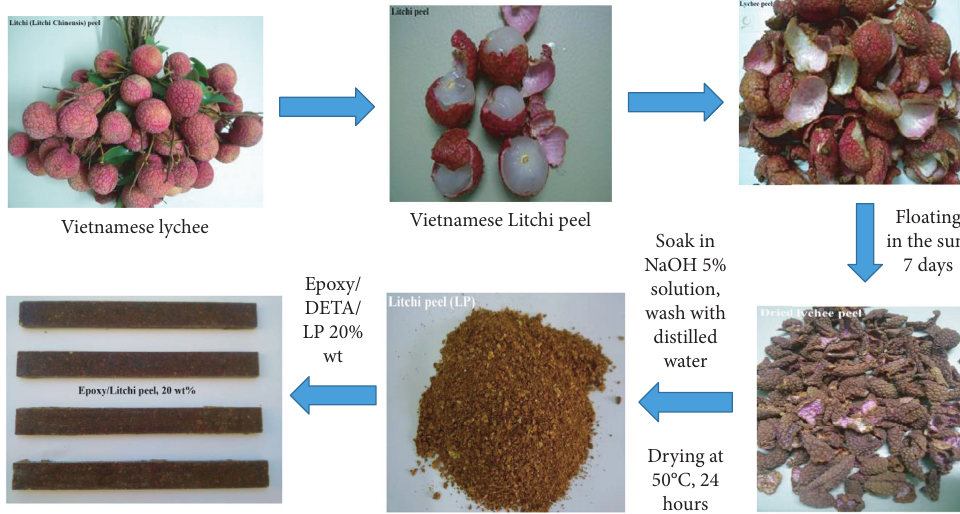
Figure 1: Retreatment process of litchi peel